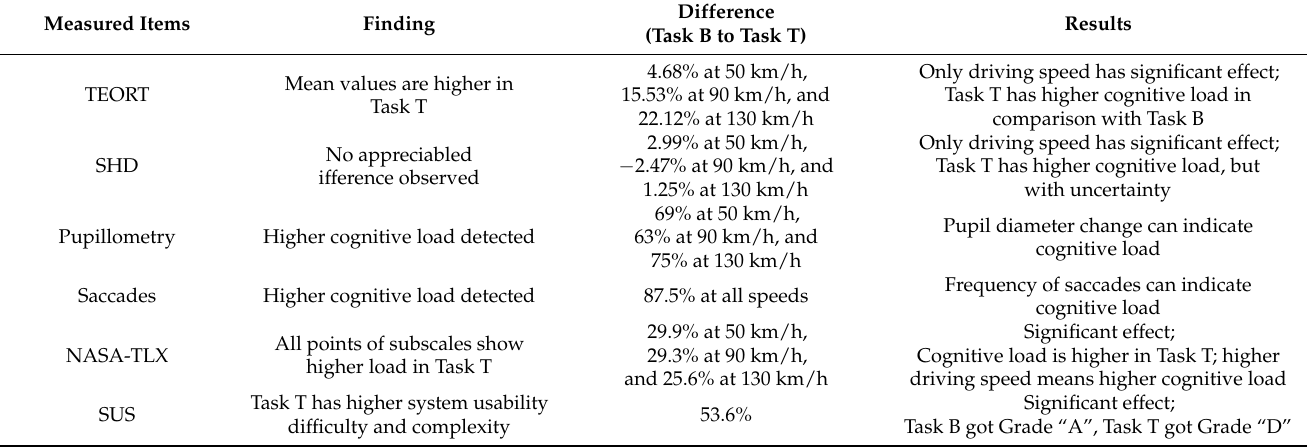
Table 14. Summary of comparison